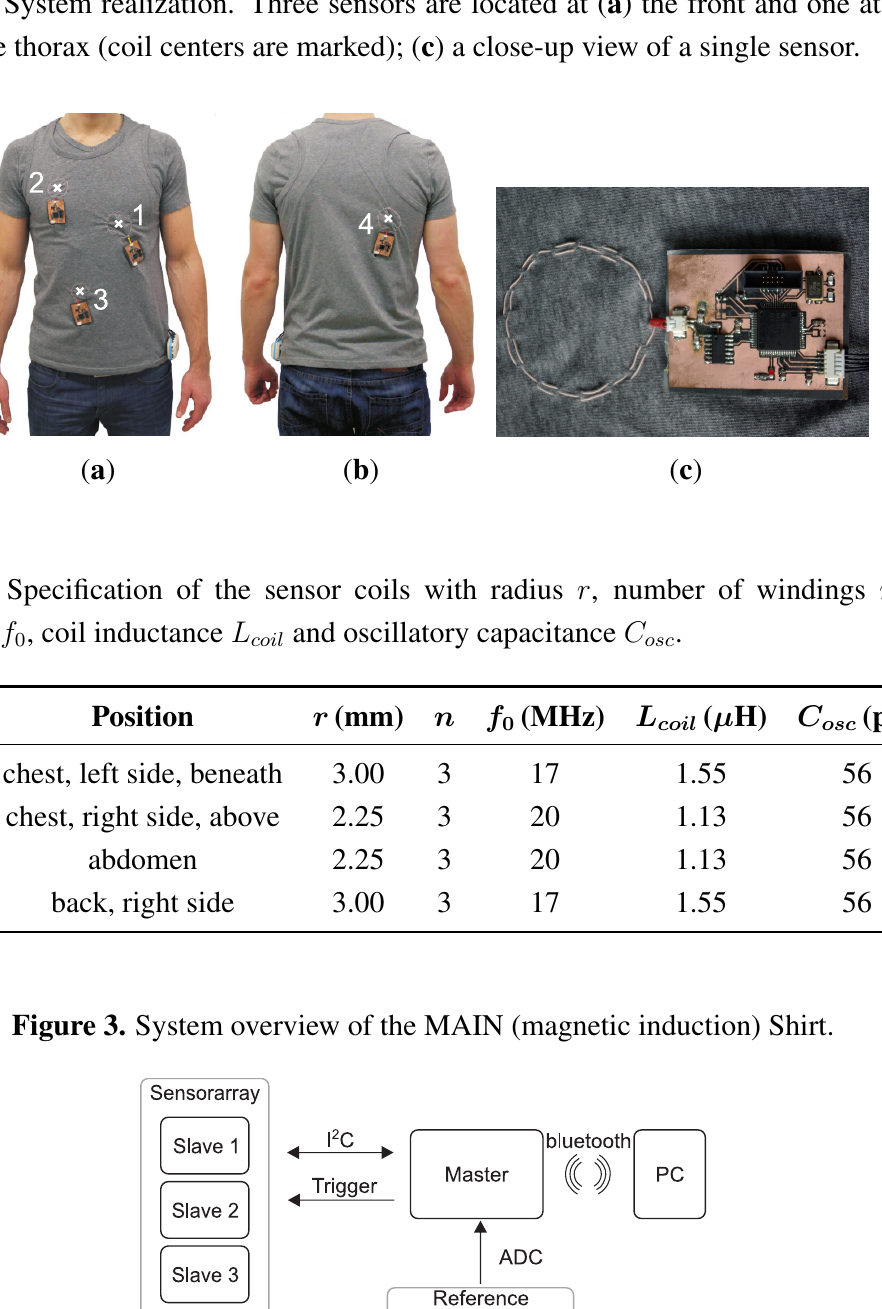
Figure 2. System realization. Three sensors are located at ( a ) the front and one at ( b ) the back of the thorax (coil centers are marked); ( c ) a close-up view of a single sensor.